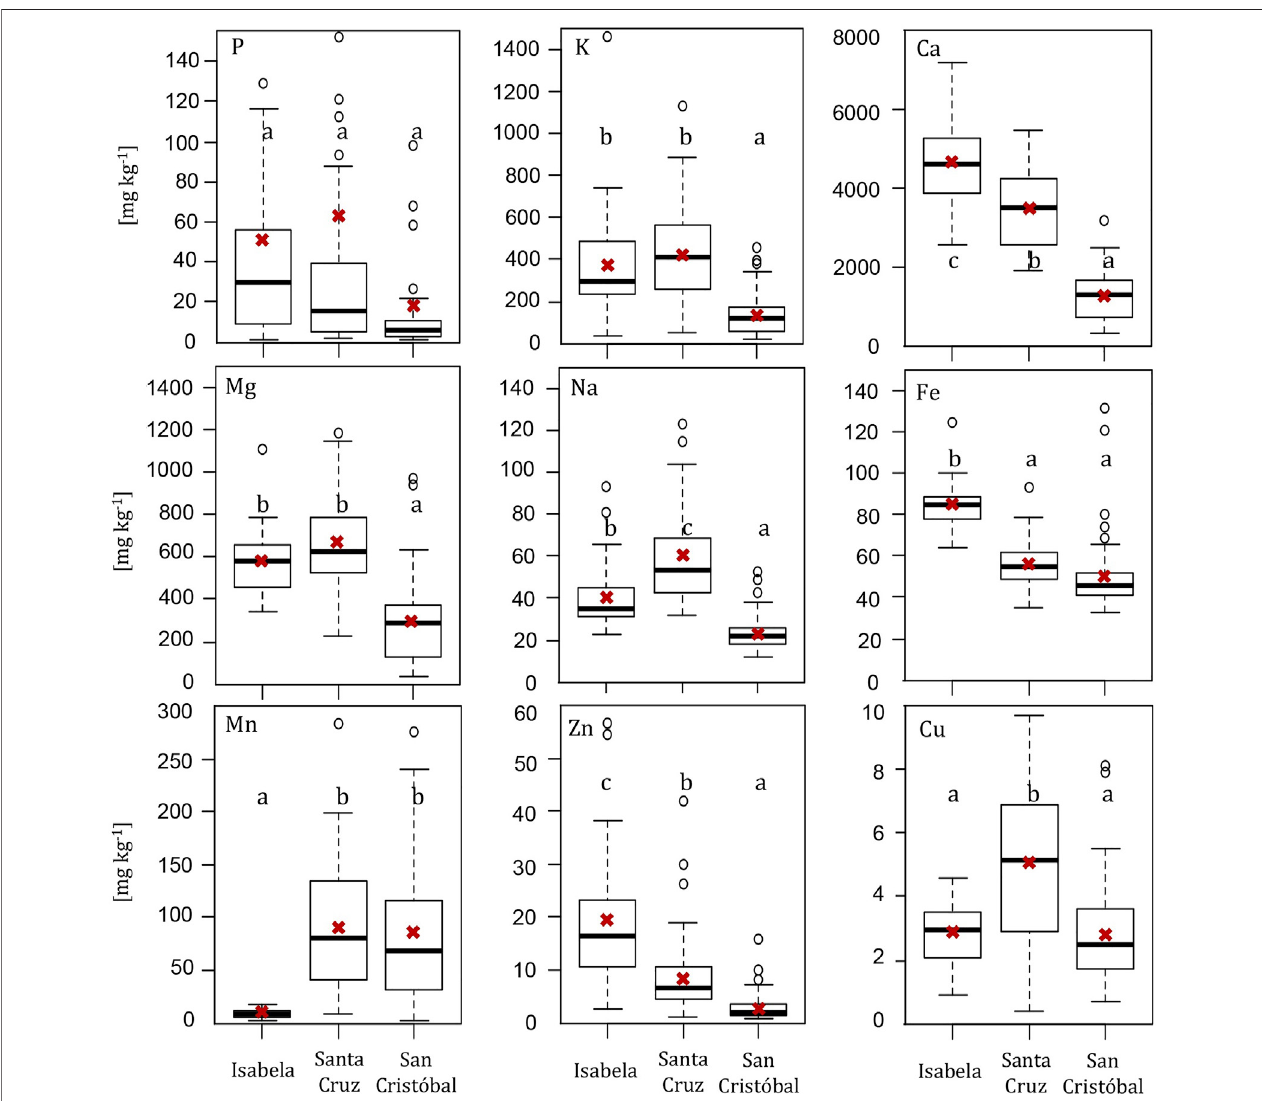
FIGURE 3 | Mehlich (III)-extractable element concentrations across the islands Isabela, Santa Cruz and San Cristóbal. Mean values are indicated by the symbol x, dots indicate outliers. Horizontal bars represent minimum, 25th percentile, median, 75th percentile and maximum. For P, fi ve extreme outliers are not displayed in the boxplot: 423 mg kg -1 on Isabela, 573 and 1,036 mg kg -1 on Santa Cruz, and 213 and 222 mg kg -1 on San Cristóbal.